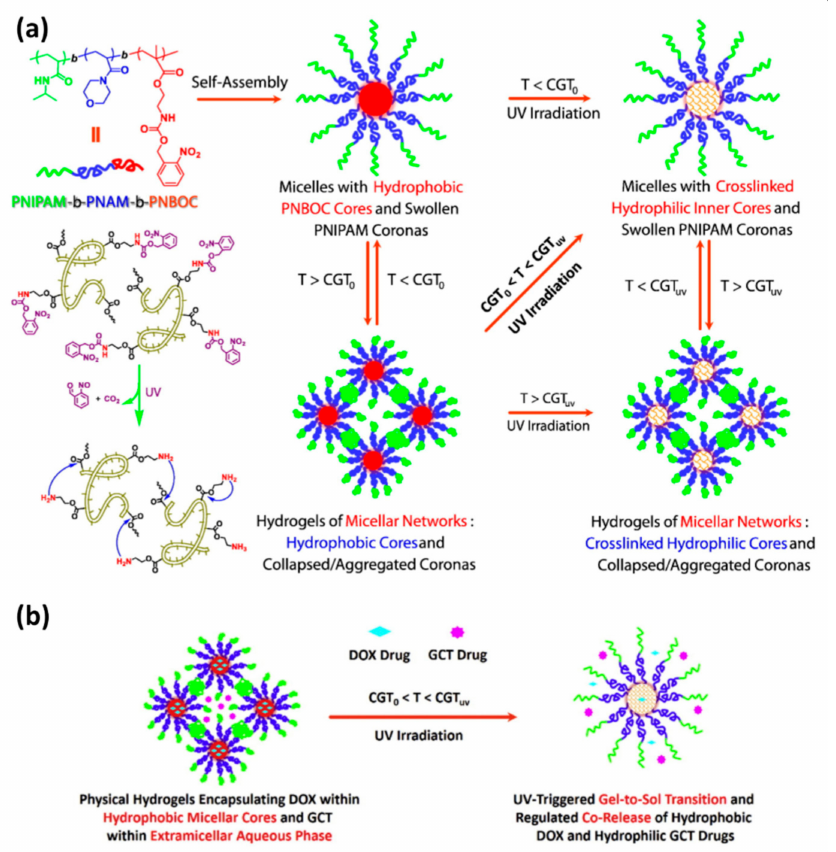
Figure 7. An example of a complex photoresponsive hydrogel: ( a ) schematics of temperature and ultraviolet (UV)-responsive micelles and supramolecular structures upon different conditions of temperature (T), critical gelation temperature before (CGT 0 ), and after (CGT UV ) UV irradiation; ( b ) scheme of UV-triggered gel-to-sol transition and co-delivery of doxorubicin (DOX) and gemcitabine (GCT) release. Copyright (2016) Elsevier B.V. Source: